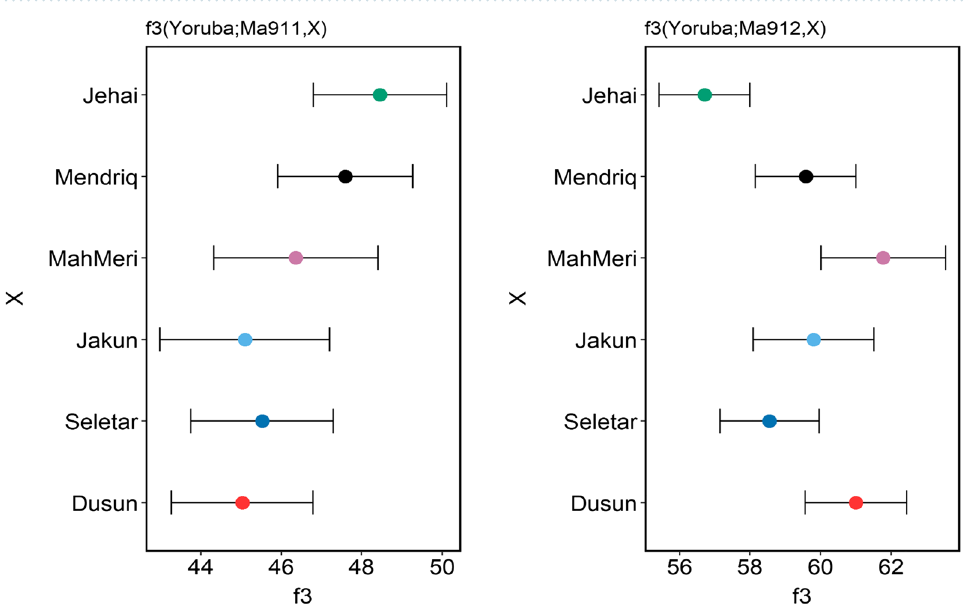
Figure 4. Allele sharing estimation using Outgroup-f3 statistics between Orang Asli and Gua Cha samples. The results indicate that Ma911 (Hoabinhian hunther-gatherer) share more drift with Malaysian Negritos (Jehai and Mendriq), while Ma912 (Neolithic farmer) share more drift with Senois (MahMeri). Plot is generated using ggplot2 version 3.3.3 package (https:// ggplo t2. tidyv erse. org/) in R version 4.0.4 (https:// www.R- proje ct.